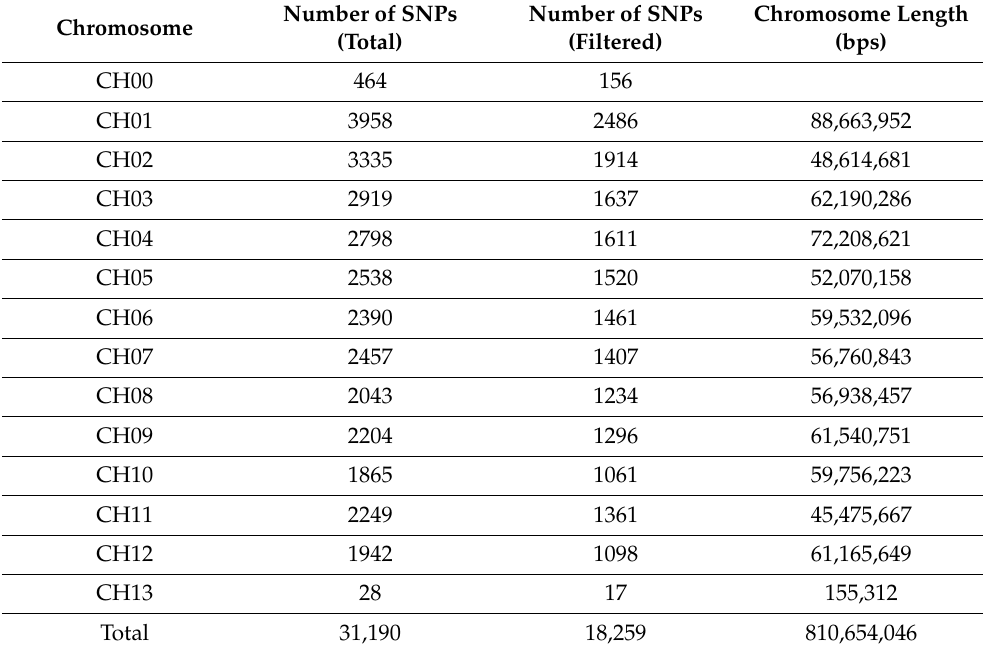
Table 2. Number of SNPs per chromosome before and after filtering and size of each chromosome. CH01 to CH12 refers to each of the 12 potato chromosomes, CH00 are control markers that are not associated with any chromosome and CH13 refers to the chloroplast.